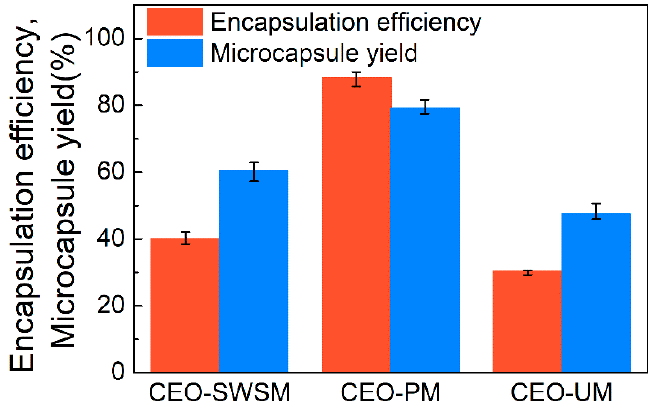
Figure 6. Encapsulation efficiencies and microcapsule yields of CEO-SWSM, CEO-PM, and CEO-UM.